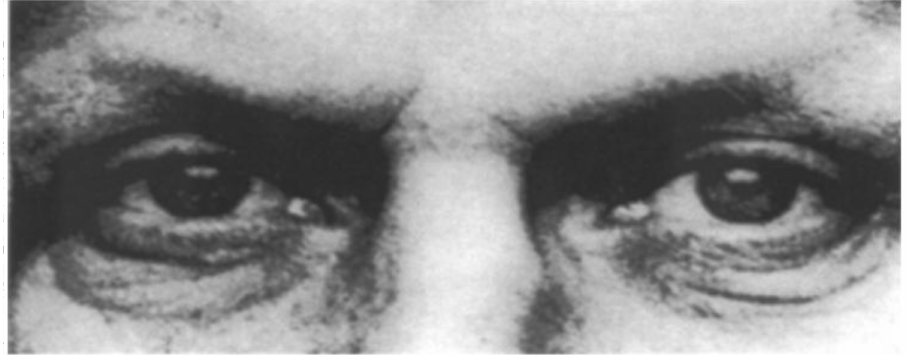
Figure 1. Mind in the Eyes Test: Example 1 (Figure 1 in